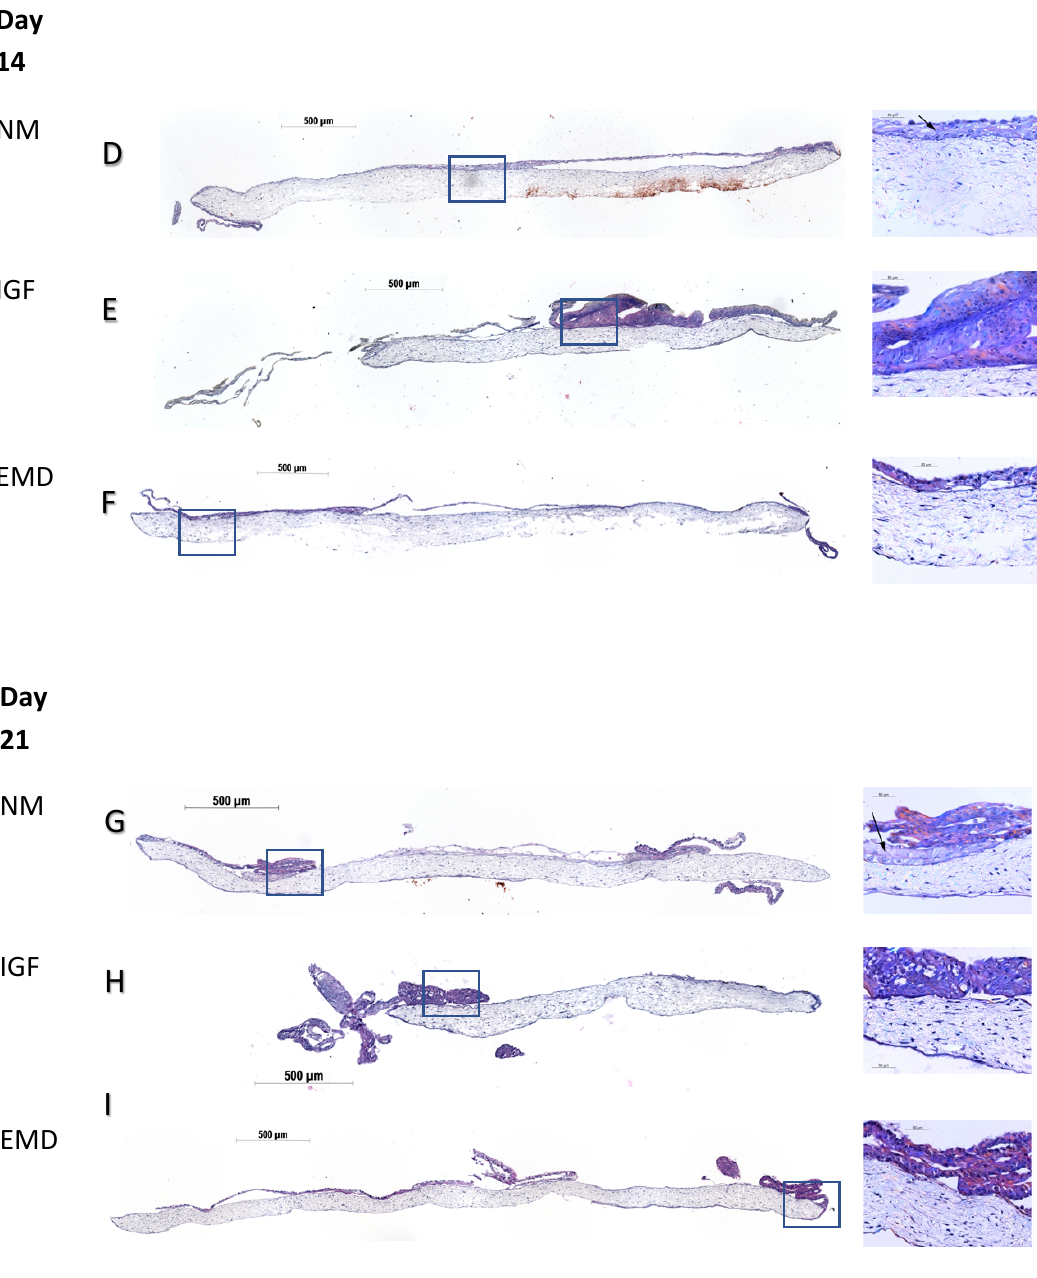
Figure 1. Cell seeding procedure assessed with histological staining. H&E stained sectioned scaffolds cultured with hDM cells and pDE cells for 3 (A-C), 14 (D-F) and 21 (G-I) days in normal medium (A, D & G), medium supplemented with IGF-I (B, E & H), and EMD (C, F & I) enriched medium. For each sample, low magnification (10x, scale bar = 500μm) image provides the overview to monitor cell-growth and visualize the cell-distribution within the scaffold. The high magnification polarized images (40x; inserts) demonstrate the presence of both dental epithelial as mesenchymal cells, as well as mineralized tissue ECM polarized structures particularly evident in NM D14 (D) and NM D21